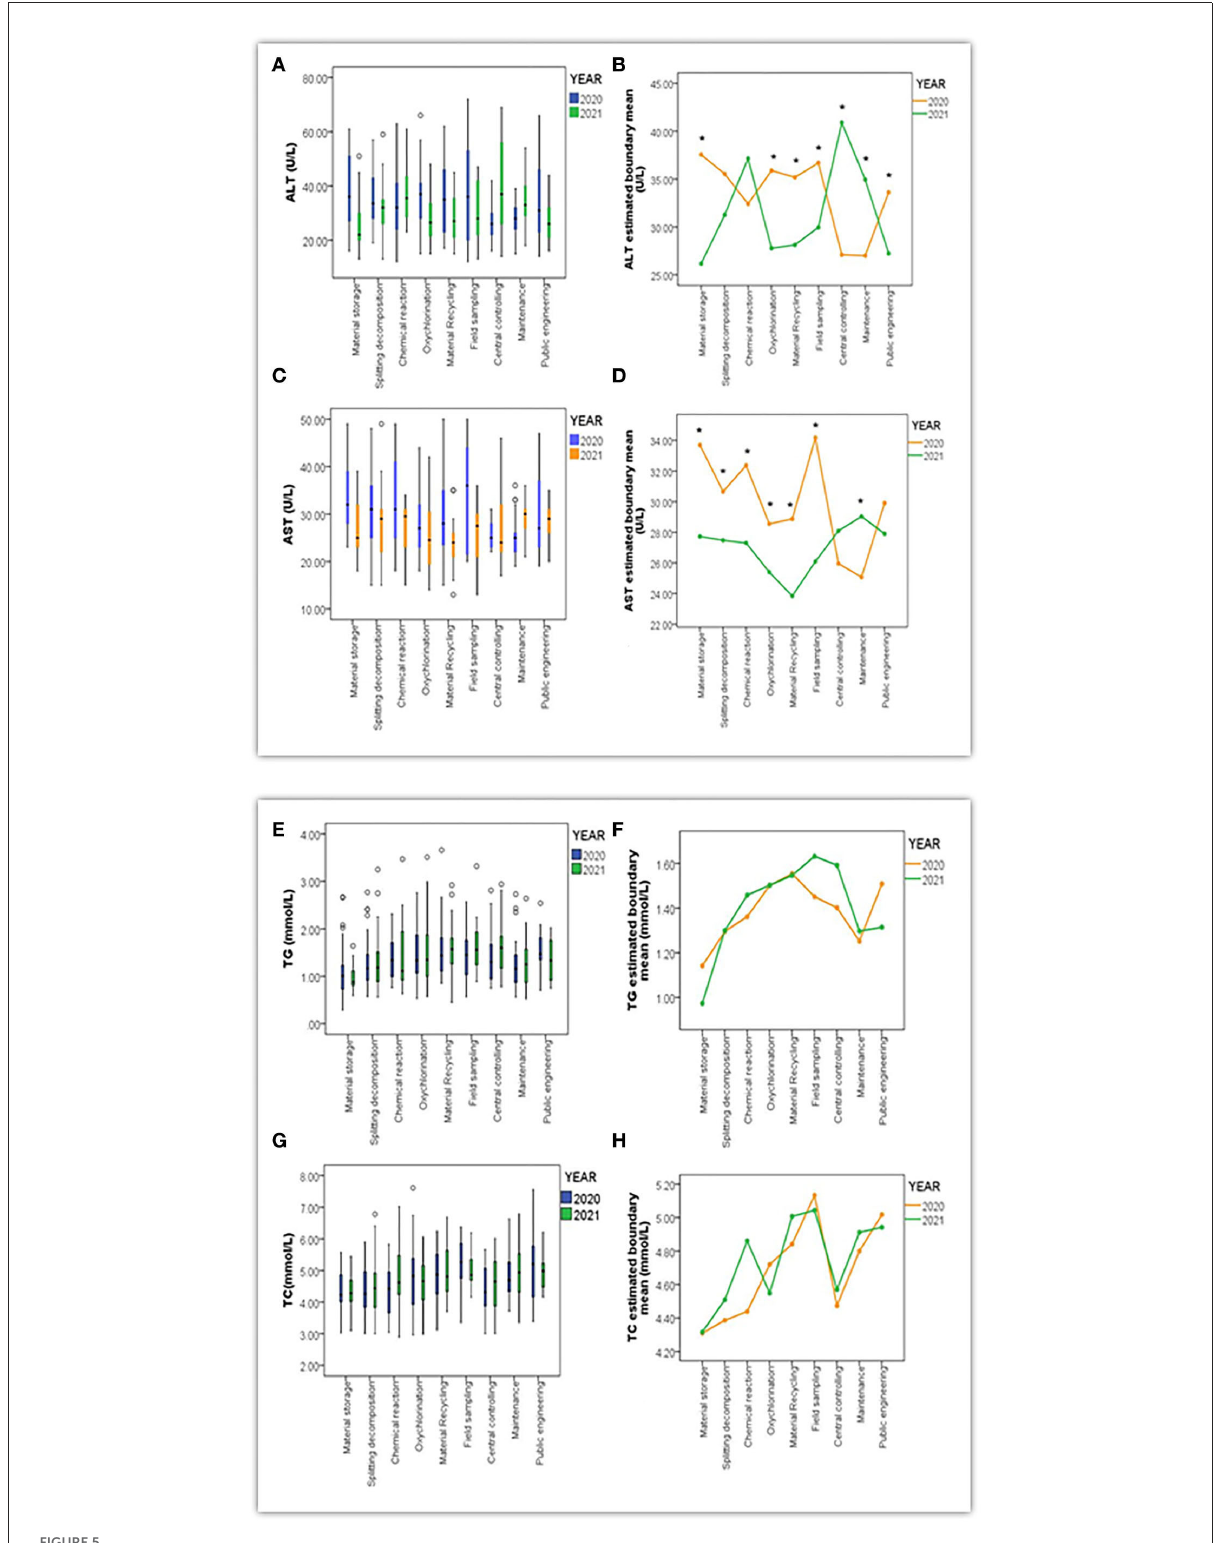
FIGURE5 Box charts (A,C,E,G) presented the quantitative distribution extent of variables in ALT (U/L) and AST (U/L), TG (mmol/L), and TC (mmol/L) throughout positions in Z between 2020 and 2021. Line Chart (B,D,F,H) indicated differentiation of estimated boundary mean for ALT, AST, TG, and TC under a bilateral interaction effect between year and position (*referred to P < 0.05 when differences among variables were